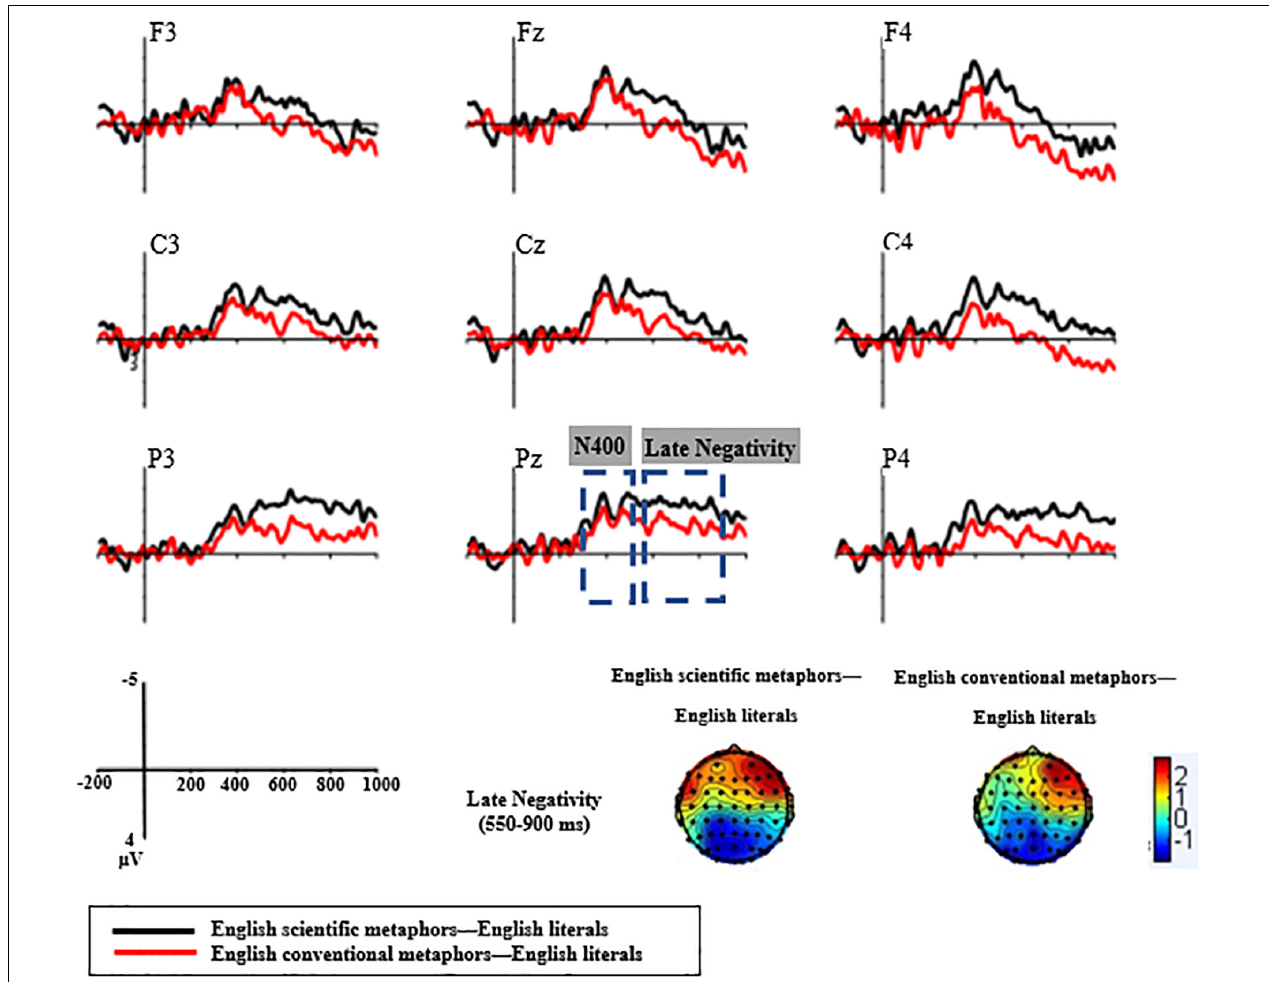
FIGURE 6 | Topographic plots of the two kinds of English metaphors subtracting the literal from the metaphoric in the 300–500 and 550–800 ms time